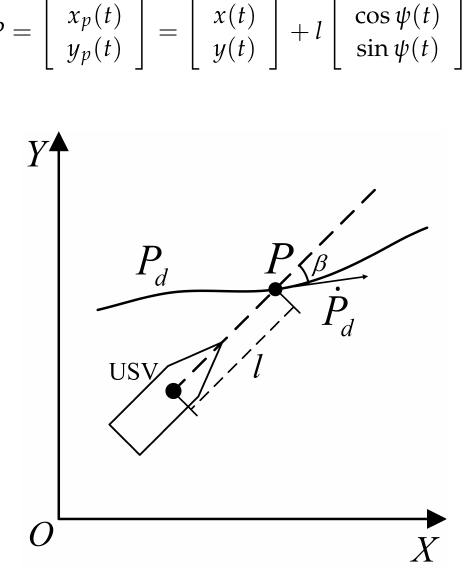
Figure 6. The virtual control point P